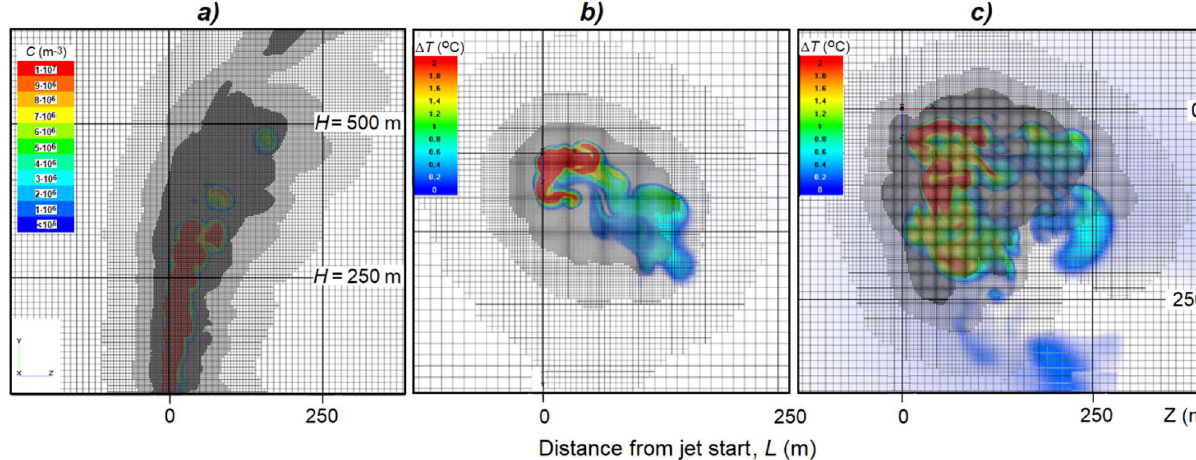
Figure 2. Computational grids (option with wind): vertical cross-section ( a ) of the aerosol concentration field ( C , m -3 ); and horizontal cross-sections of the temperature excess fields (Δ T , o C) at altitudes H = 250 ( b ) and 450 m ( c ) from the jet start level.